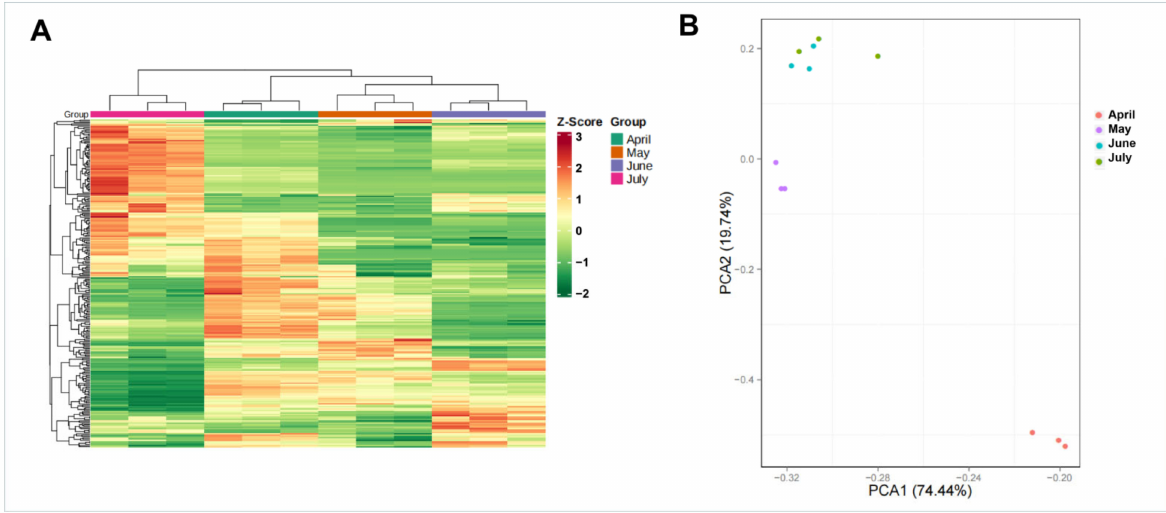
Figure 3. Gene expression levels during four A. argyi developmental stages. ( A ) Clustering dendro- gram of gene expression patterns in different A. argyi developmental stage samples. ( B ) PCA of gene expression profiles for different A. argyi developmental stage